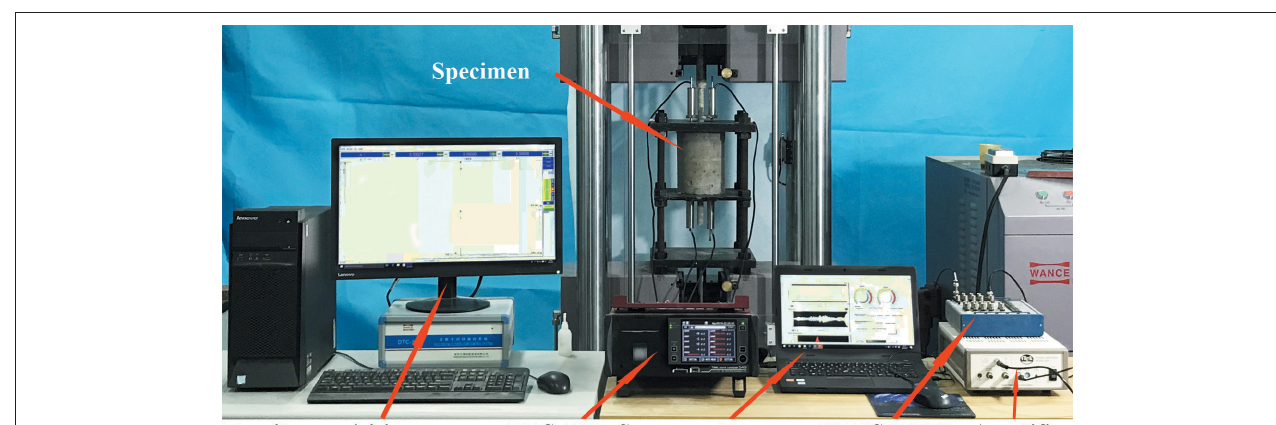
FIGURE 2 | Experimental